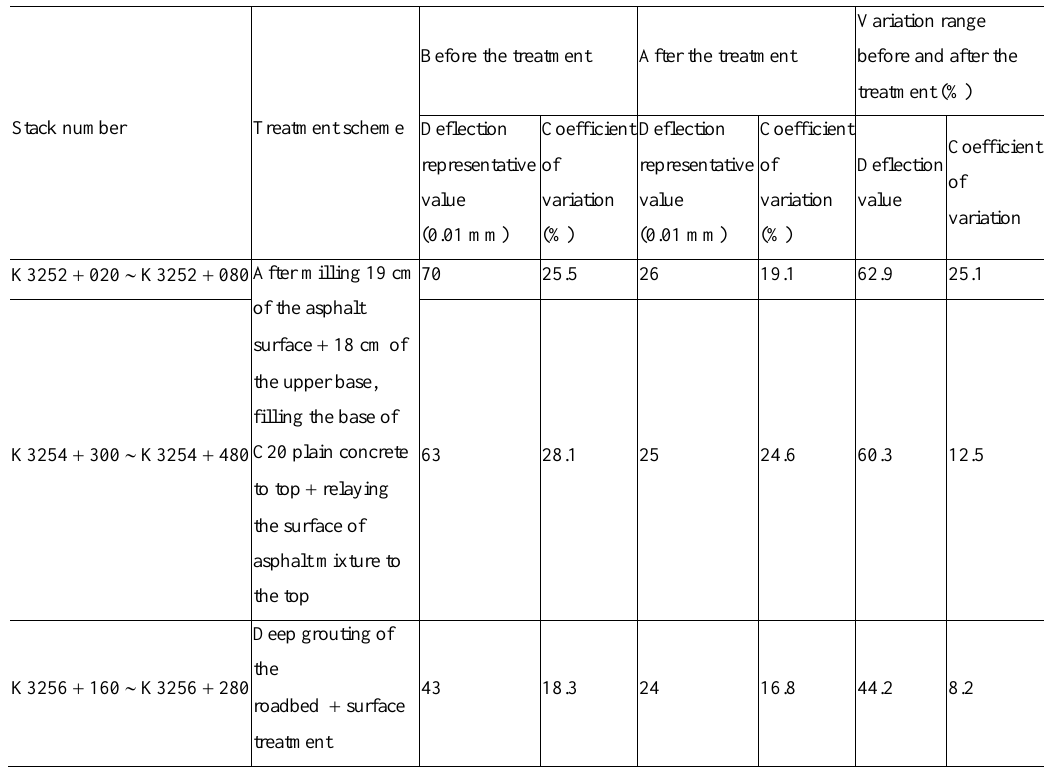
roadbed + surface